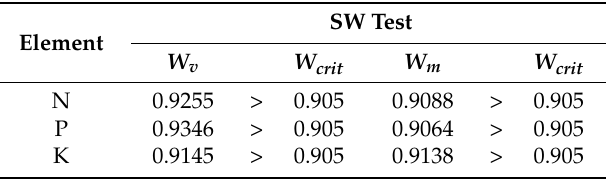
Table 6. The values of test statistic W ( v for calculated, m for measured data) in testing of H 0 and H 1 hypotheses using the SW test of conformity and their comparison with the critical